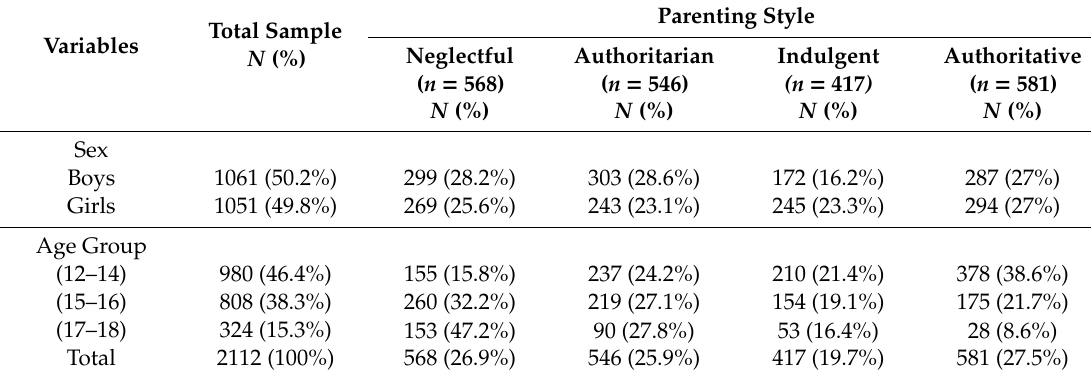
Table 1. Sociodemographic